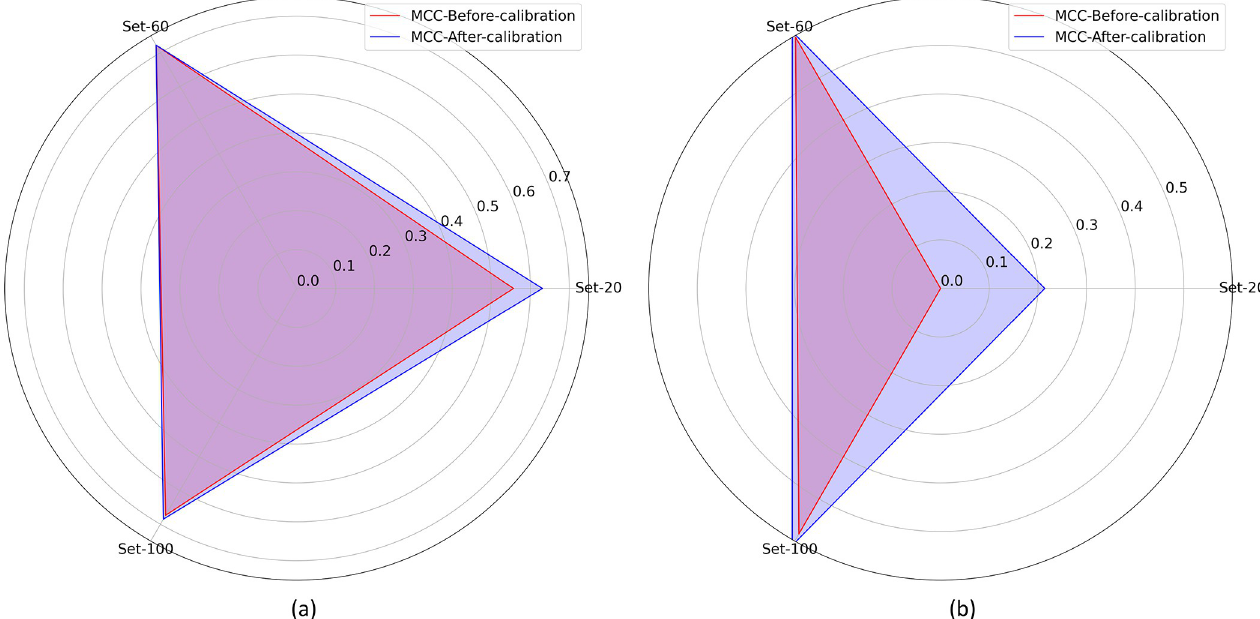
Fig 5. Polar coordinates plot showing the MCC metric achieved at the default operating threshold of 0.5, by the DenseNet-121 and VGG-16 models using calibrated and uncalibrated probabilities generated from Set-20, Set-60, and Set-100 datasets for (a) APTOS’19 fundus and (b) Shenzhen TB CXR data collections, respectively.